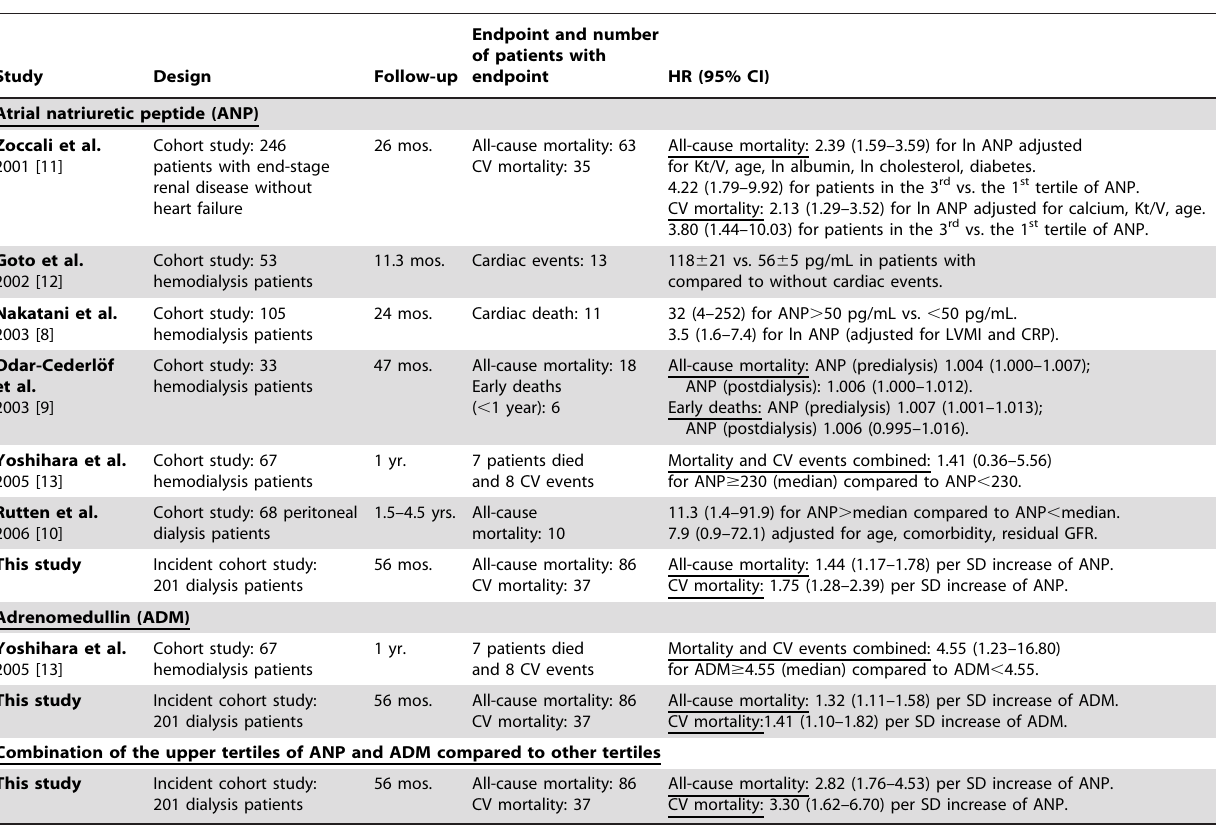
Table 5. Prospective studies in dialysis patients investigating the association between atrial natriuretic peptide (ANP) and adrenomedullin (ADM) on clinical